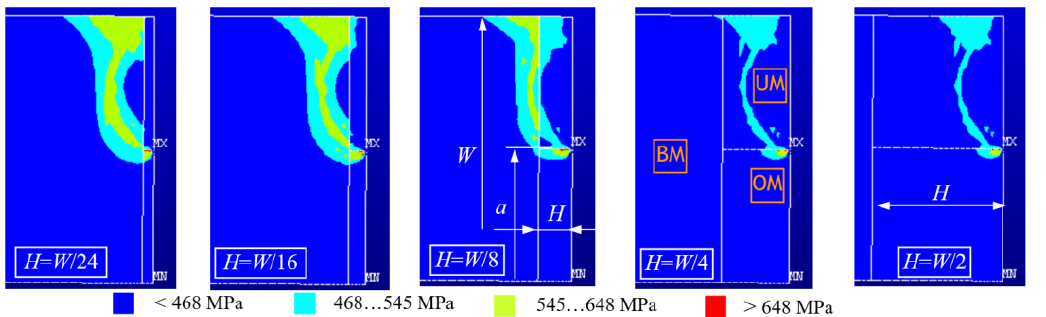
Figure 4. Mismatch yield loads for the heterogeneous weld and for a crack in the over-matched part of the weld: ( a ) shallow crack — a / W = 0.1; ( b ) medium length crack — a / W = 0.3; ( c ) deep crack — a / W = 0.5.